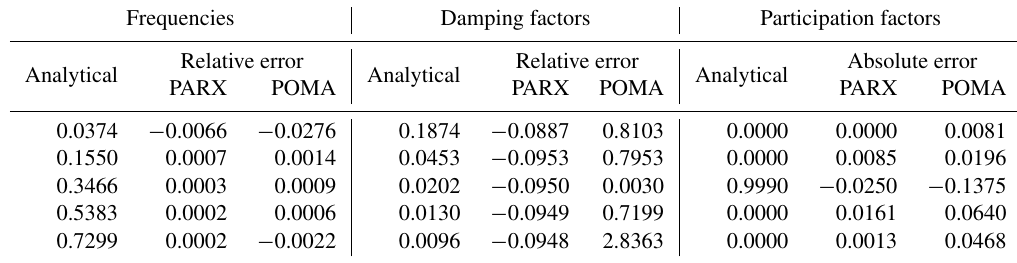
Table 5. Analytical results and estimation errors of tower side–side modal